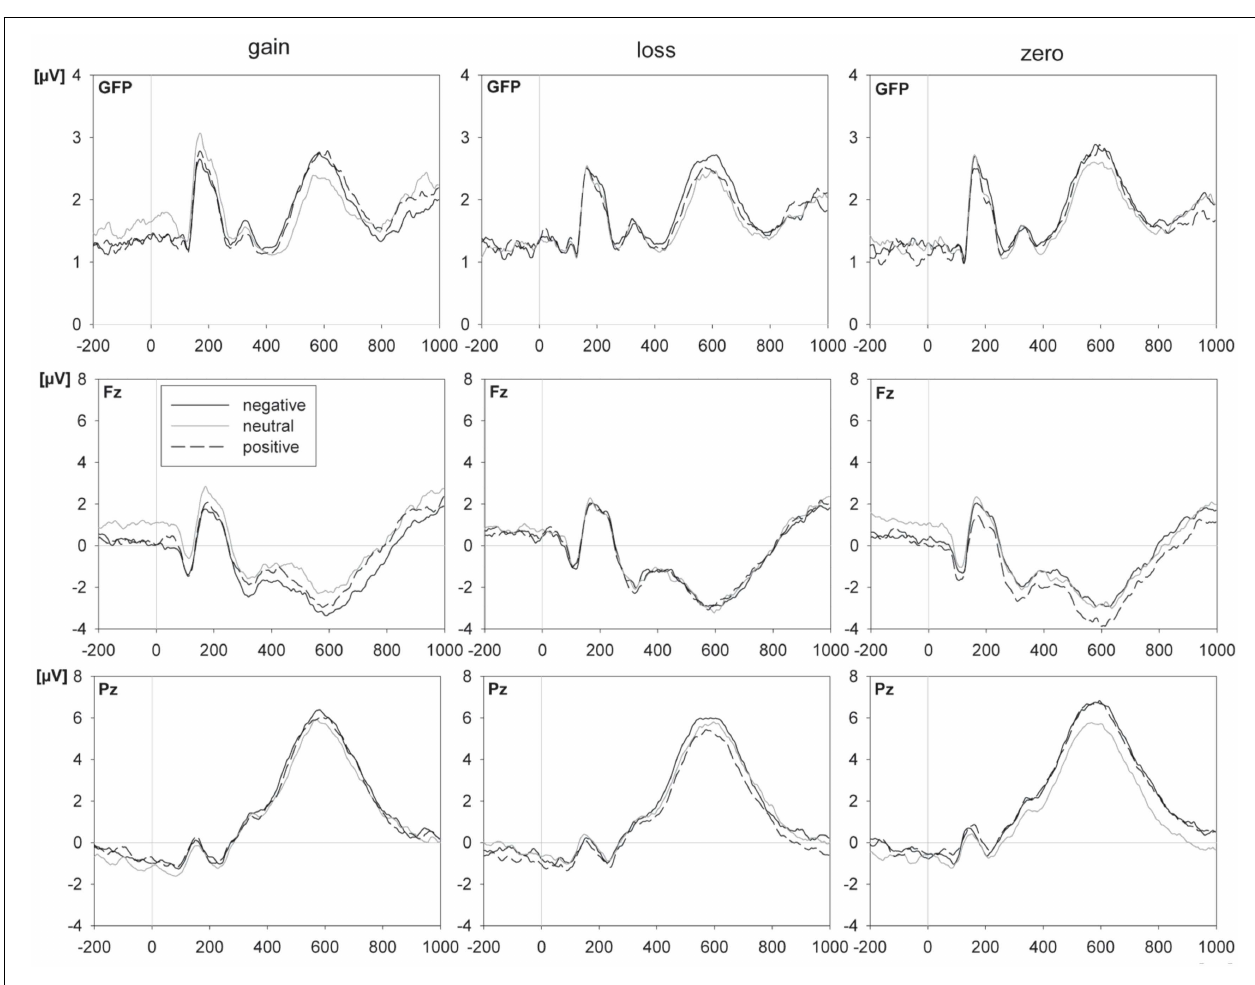
FIGURE 5 | ERP effects of emotional word valence as a function of reward